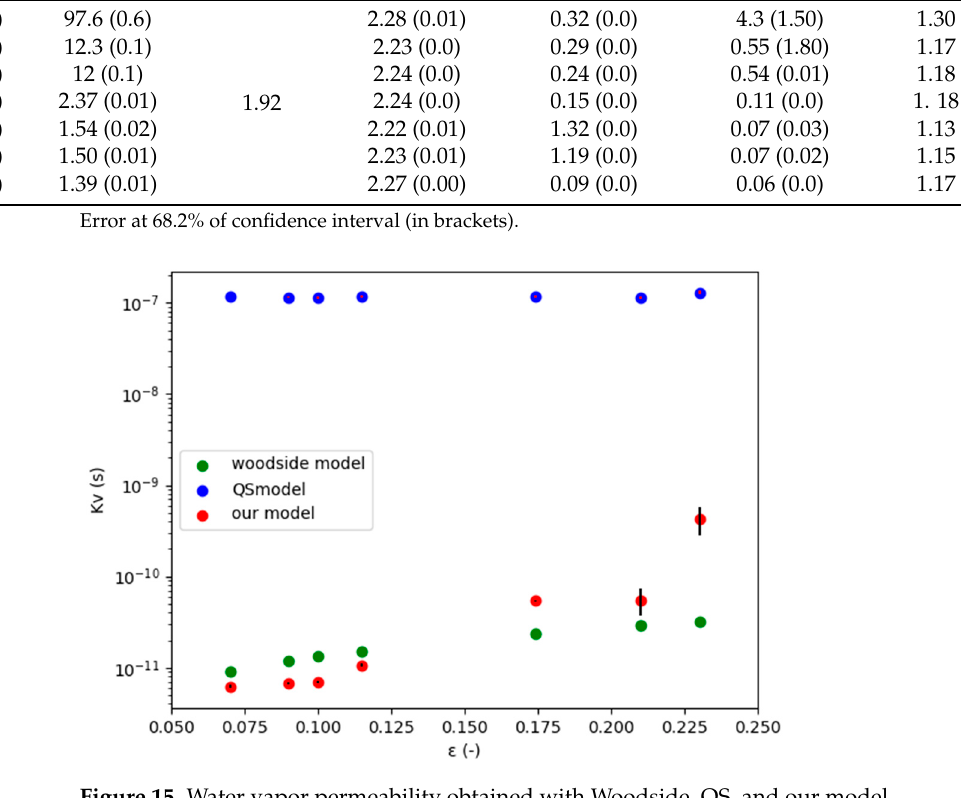
Figure 15. Water vapor permeability obtained with Woodside, QS, and our model.